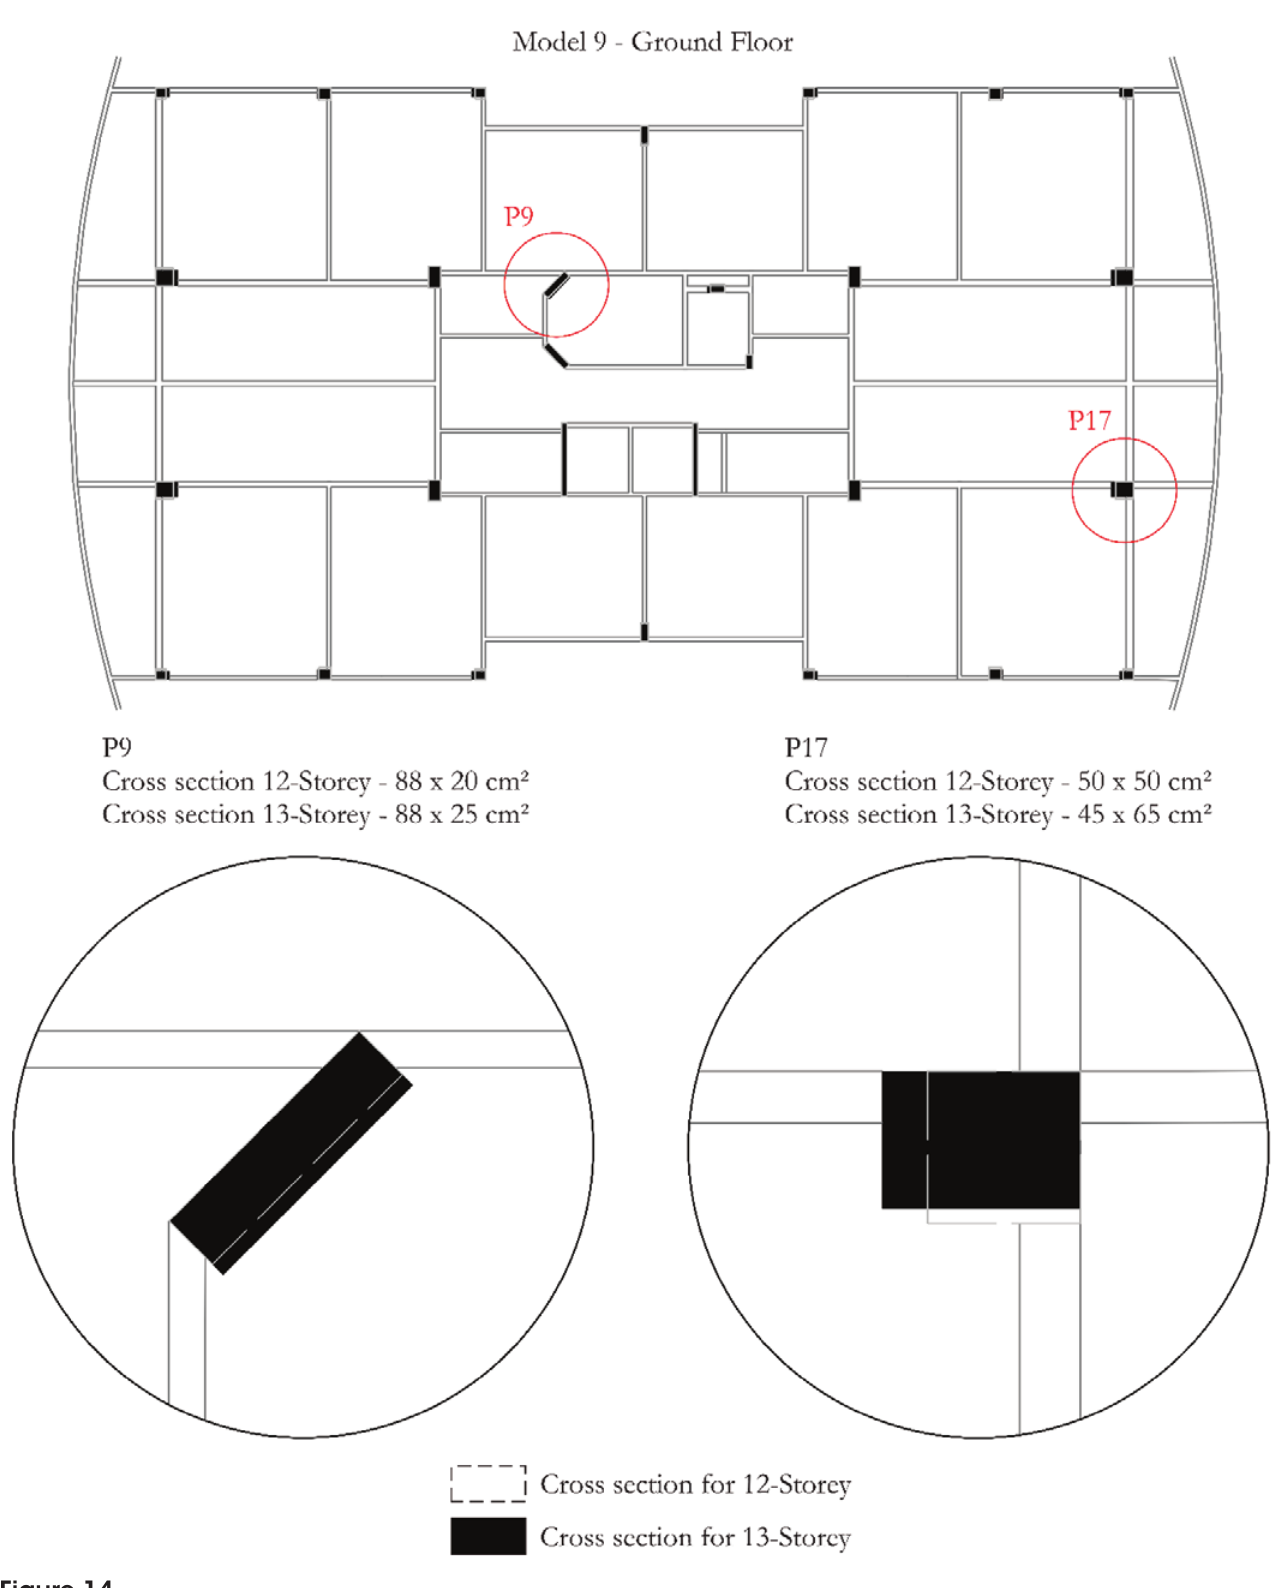
Cross section of P9 and P17 columns in the ground floor for 12-storey and 13-storey structures – Model